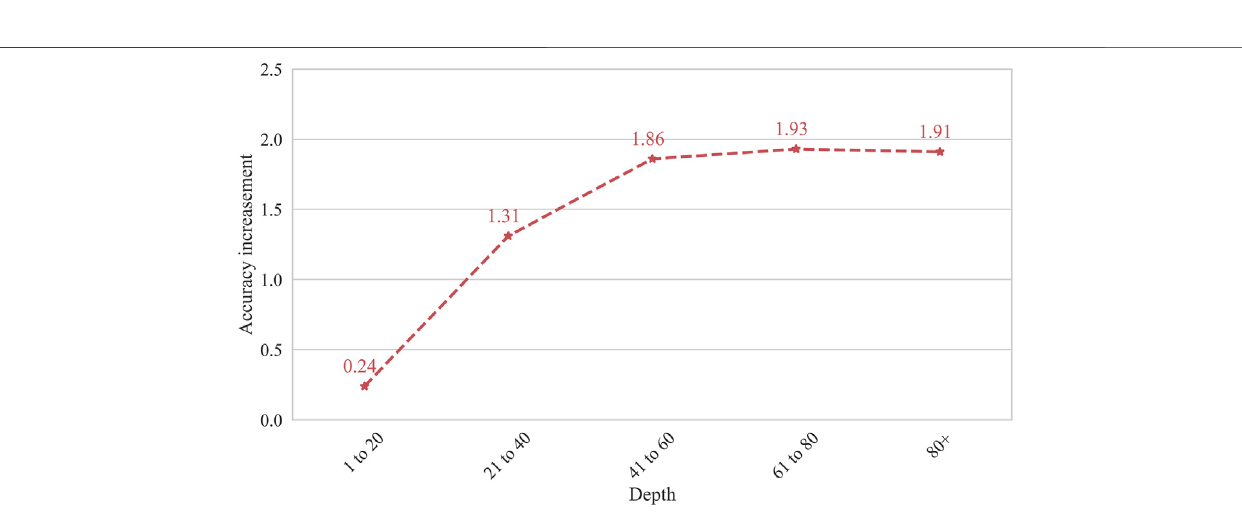
Frontiers in Physics |